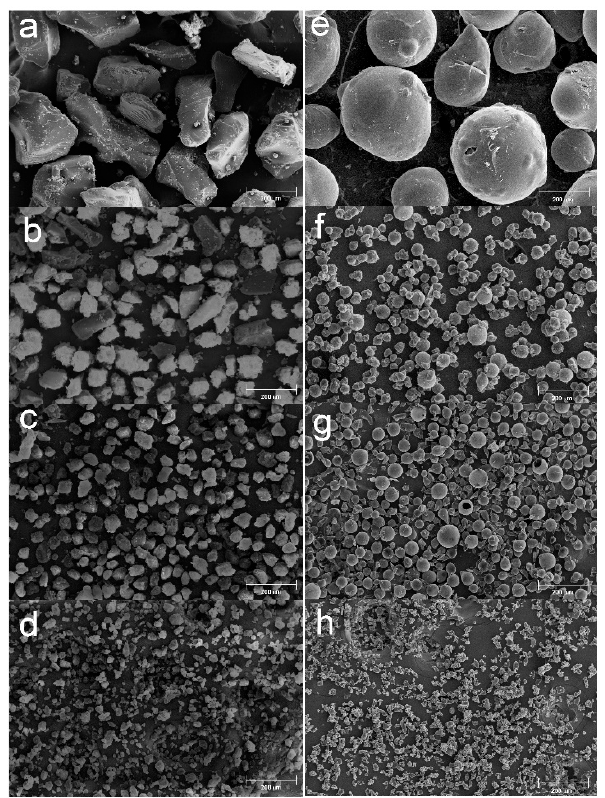
Figure 2. ( a )SEM micrographs of LcNS > 100 µ m, ( b ) Linecaps nanosponge (LcNS) 71–100 µ m, ( c ) LcNS 40–71 µ m, ( d ) LcNS < 40 µ m, ( e ) C-LcNS > 100 µ m, ( f ) C-LcNS 71–100 µ m, ( g ) C-LcNS 40–71 µ m, Figure 2. a )SEM micrographs of LcNS > 100 μ m, b ) Linecaps nanosponge (LcNS) 71–100 μ m, c ) LcNS ( h ) C-LcNS < 40 µ m. Magnification: 100 × 40–71 μ m, d ) LcNS < 40 μ m, e ) C-LcNS > 100 μ m, f ) C-LcNS 71–100 μ m, g ) C-LcNS 40–71 μ m, h ) C-